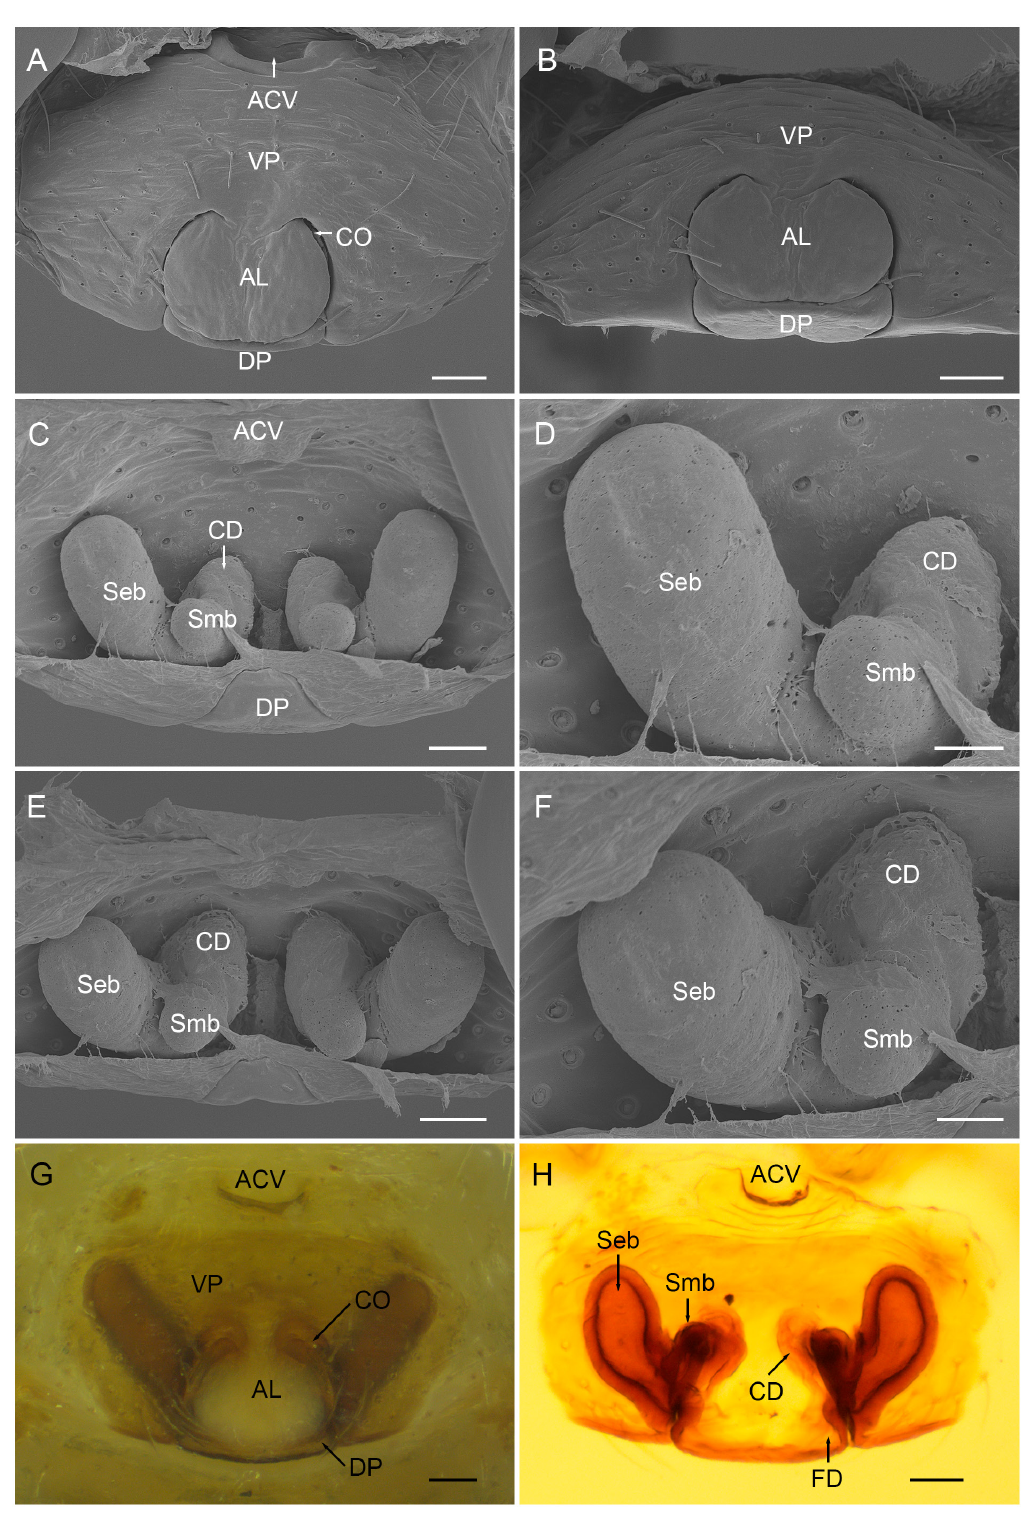
Fig. 5. Xim trenzado gen. et sp. nov., ♀, epigynum. A–B . ECOTAAR-005063. C–F . ECOTAAR-005183. A, G . Ventral view. B . Posterior view. C–D, H . Dorsal view. D . Detail of C showing left copulatory duct and spermatheca. E . Antero-dorsal view. F . Detail of E showing left copulatory duct and spermatheca. Scale bars: A–C, E, G–H = 40 μm; D, F = 20